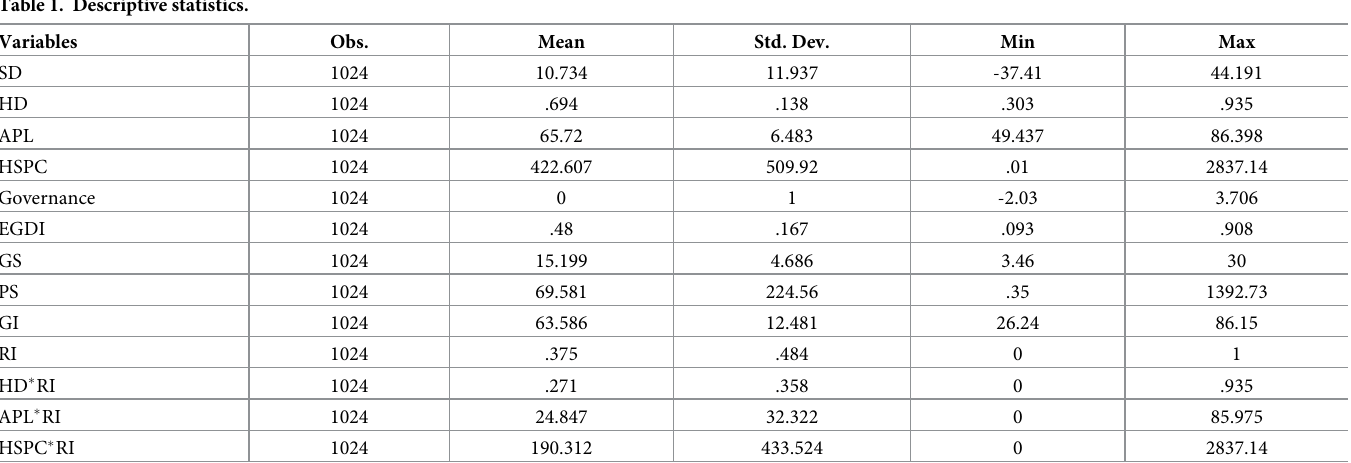
Table 1. Descriptive statistics.